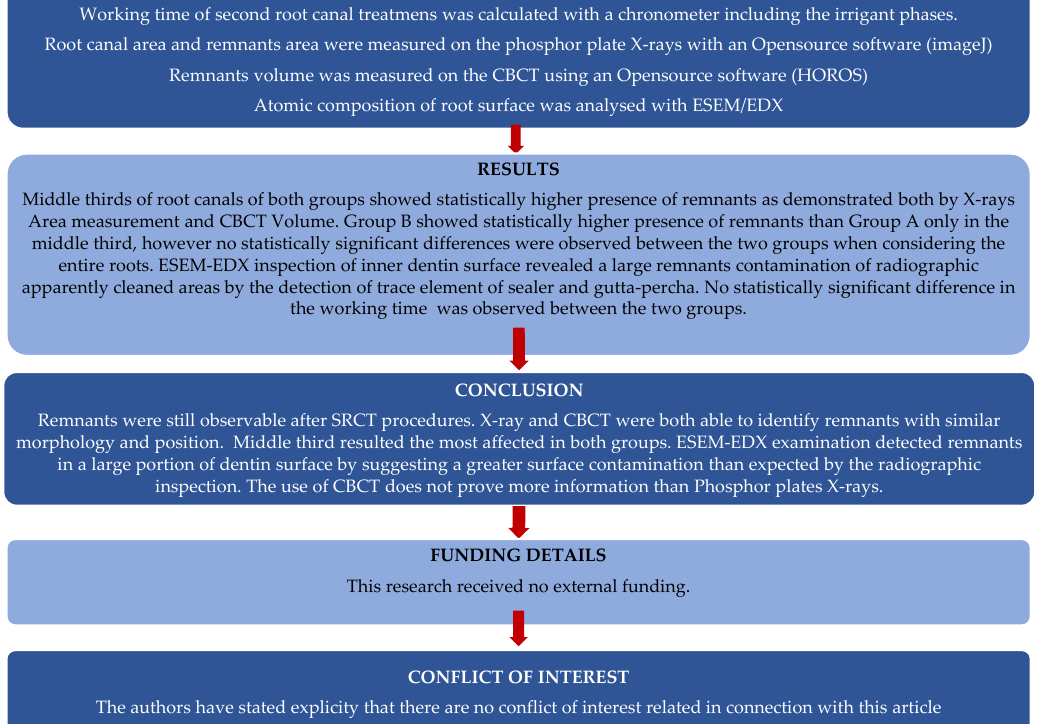
Figure 1. PRILE 2021 Flowchart.